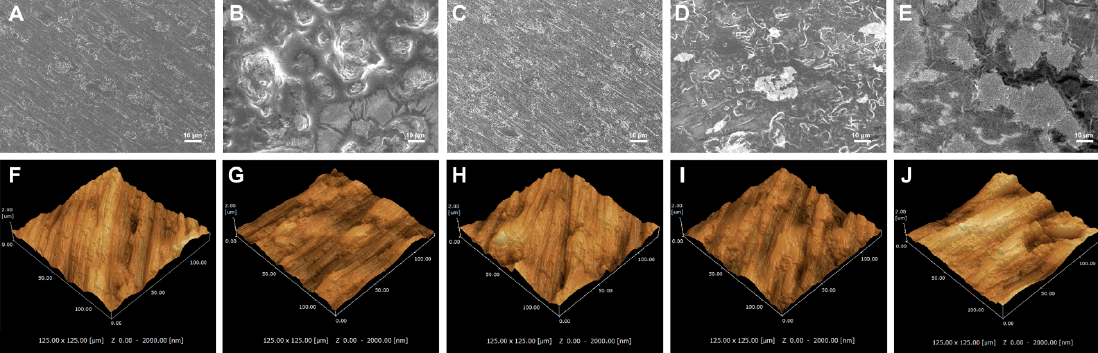
Figure 3. Characterization of the surfaces of the samples. ( A–E ) Scanning electron micrograph of Ti, Tallow-Ti, Finevo-Ti, Plasma-Ti, and UV-Ti (magnification = 1000×), scale bar = 10 μ m. ( F–J ) Scanning probe microscopic images of Ti, Tallow-Ti, Finevo-Ti, Plasma-Ti, and UV-Ti.